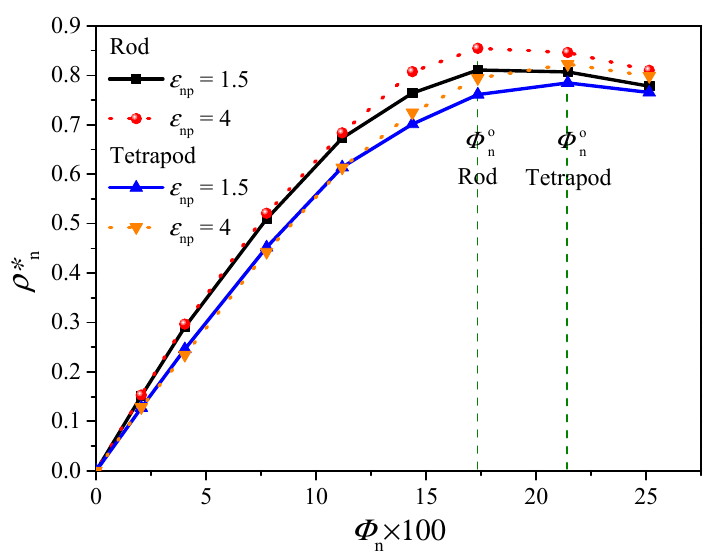
Figure 9. Plot of number density, ρ * n , of nearest neighbor polymer beads versus nanoparticle concentration, Φ n , for tetrapod and rod nanocomposites.